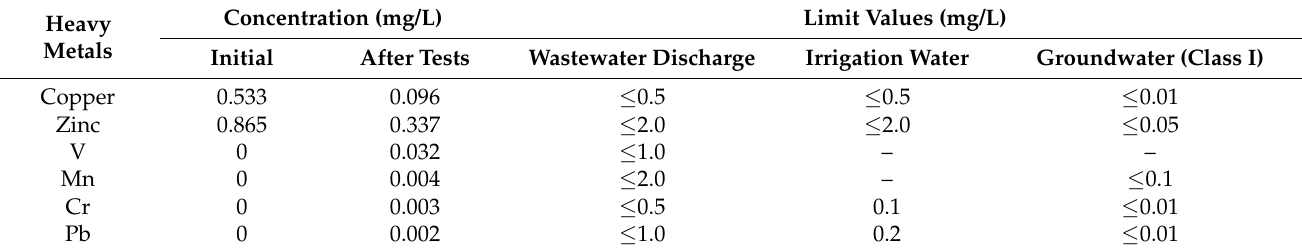
Table 4. Concentration of heavy metal in runoff solution infiltrating through BOF slag porous asphalt concrete.